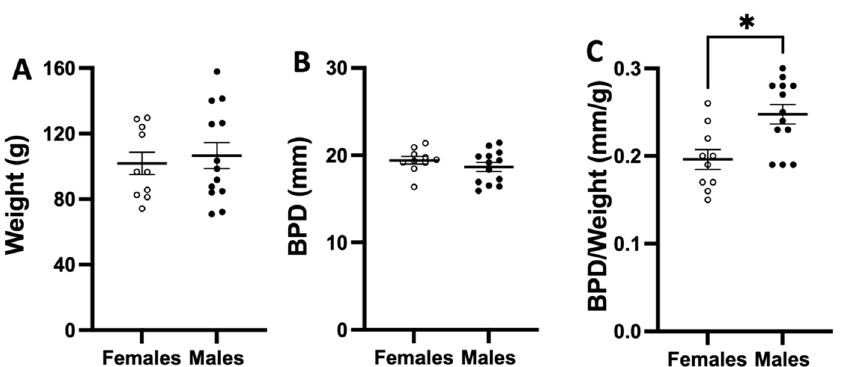
Figure 5. Neonatal biometry at birth. Neonatal ( A ) weight, ( B ) biparietal diameter (BPD), and ( C ) BPD to neonatal weight ratio of female (white circles, n = 10) and male (black circles, n = 13) guinea pigs. Data were analyzed by Mann–Whitney t -test. Significant differences when p < 0.05 (*).